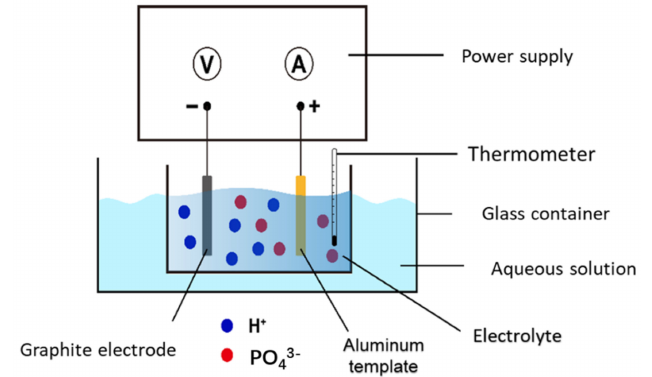
Figure 1. Anodic oxidation